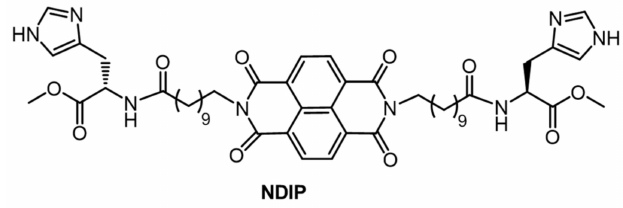
Figure 11. Molecular structure of